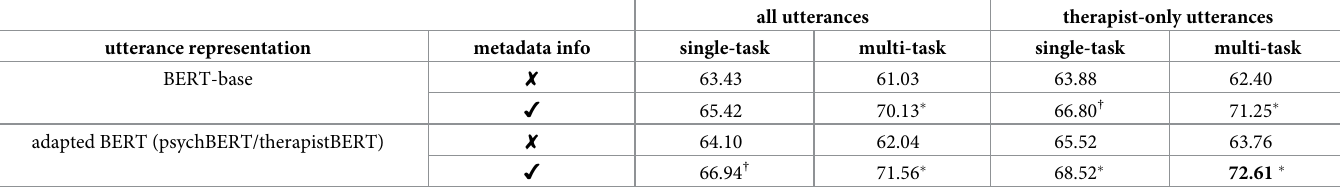
Table 5. F 1 score (%) based on 10-fold cross validation.